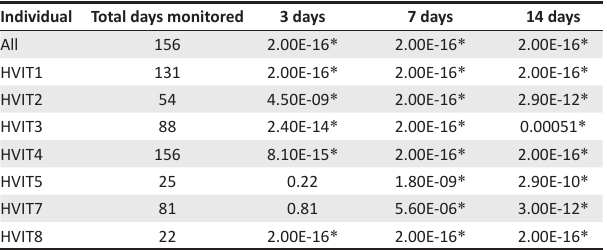
TABLE 2: A summary of the difference between activity rates between the three hypothesised recovery periods and the rest of the activity rates for the rest of the data set in the present study.